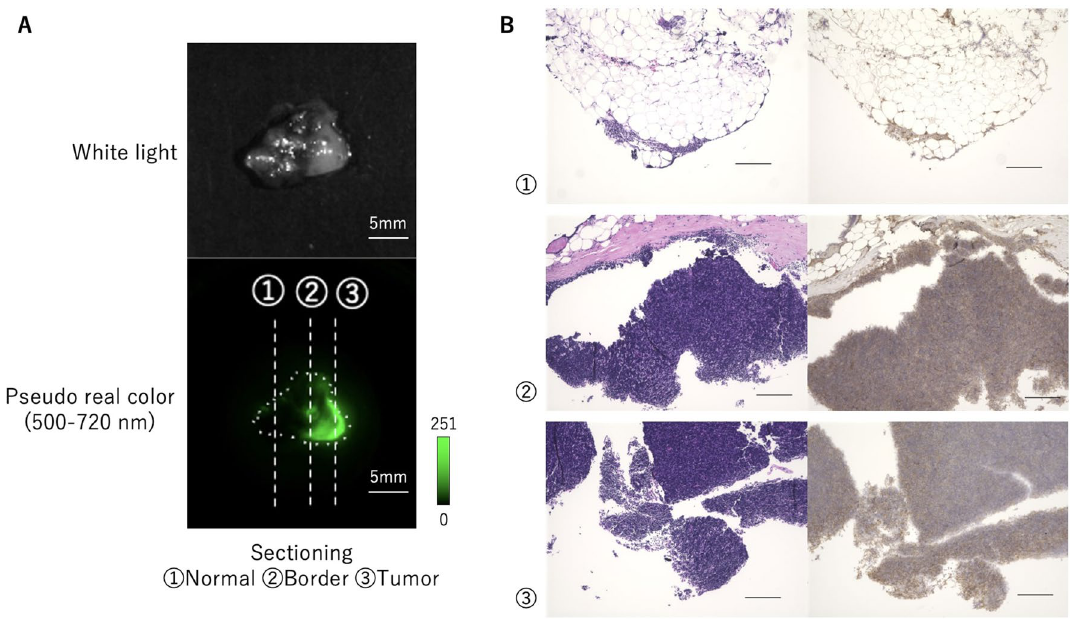
Figure 5. Application of gGlu-HMRG for specific demarcation of thymoma. ( A ) Fluorescence image of surgically resected thymoma specimen containing both normal and tumor tissues after administration of gGlu- HMRG. Tumor area fluoresced well (3) and normal area did not (1), so the border between tumor and normal area could be confirmed (2) by the fluorescence imaging. Scale bar, 5 mm. ( B ) Left: Pathological HE-staining of the same specimen shown in ( A ), sectioned along the indicated lines. Areas of increased fluorescence coincided well with pathologically confirmed thymic tumor regions. Right: IHC staining for GGT. Scale bar, 200